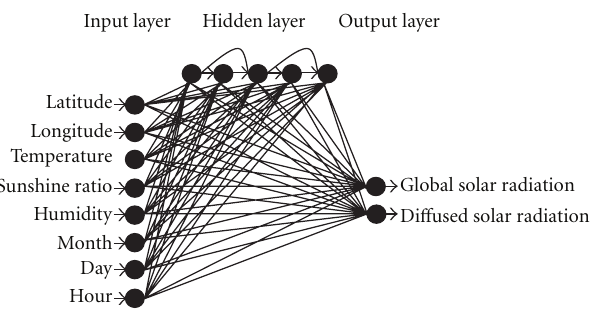
Figure 3: CFNN for solar radiation